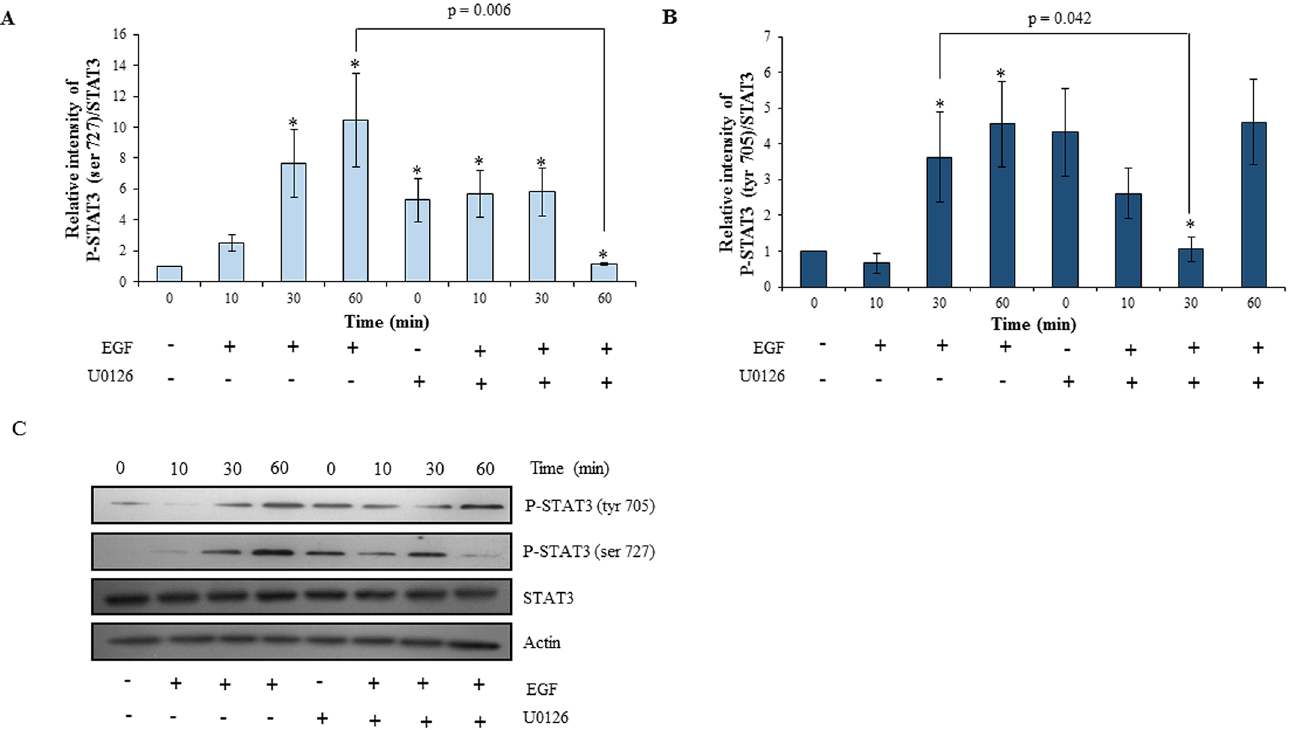
Fig 4. Effect of inhibition of ERK ½ signaling in HTR-8/SVneo cells on EGF-mediated STAT3 activation. HTR-8/SVneo cells with or without pretreatment of U0126 for 2 h, were treated with EGF (10 ng/ml) for varyingtime points (10, 30 and 60 min) and Western blotting was performed as describedin Materials and Methods . PanelsA and B represent the densitometric profiles of P-STAT3 ser 727 and tyr 705 levels as comparedto STAT3 total at 10, 30 and 60 min after EGF treatment of HTR-8/SVneo cells (with or without U0126 pre-treatment) with respect to untreated control respectively.Panel C shows the representative blots from one of the three independentexperiments. The data is shown as mean ± SEM of three independentexperiments and band intensitieswere normalized with respect to loadingcontrol duringdensitometric analysis. * p < 0.05 with respect to untreatedcontrol